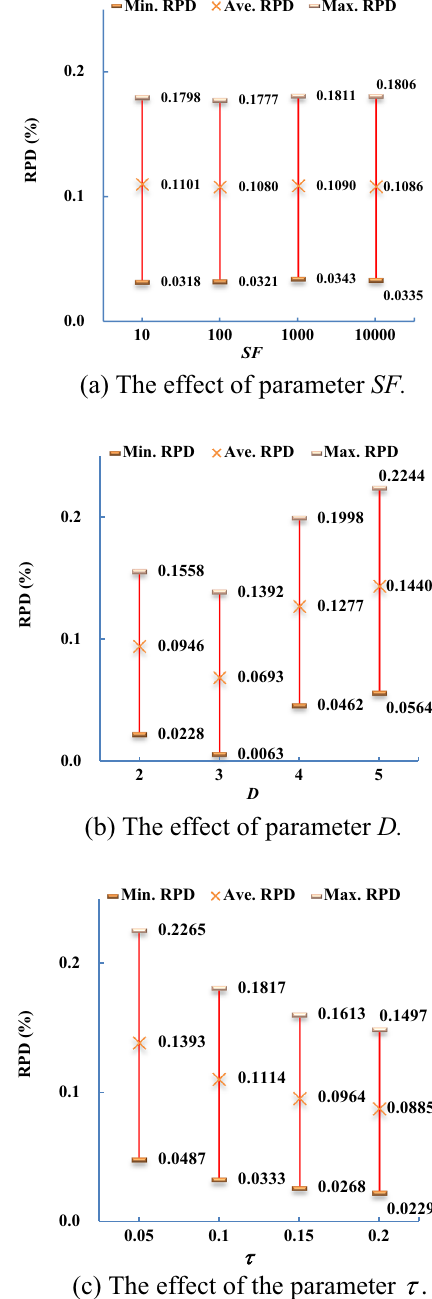
Figure 4. The effect of each parameter on the solution